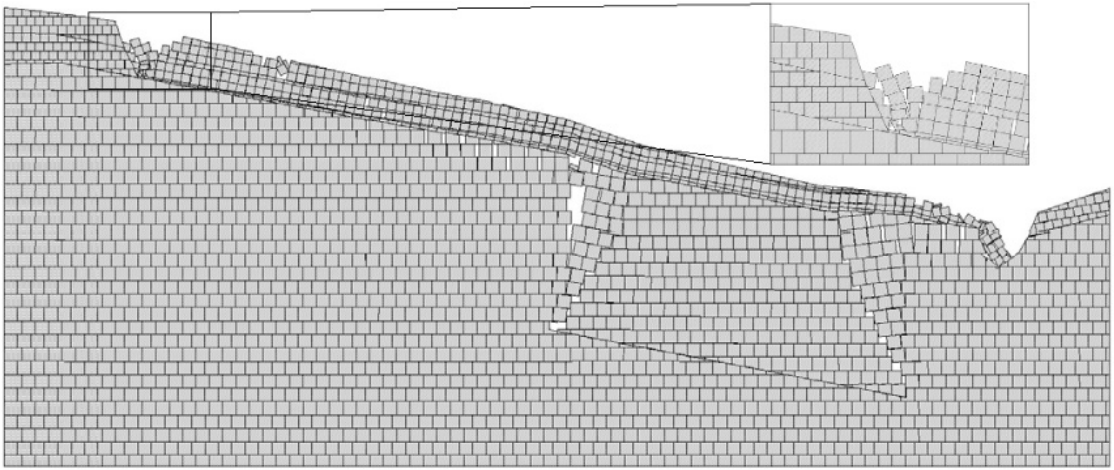
Figure 9. Iterative 607,693-step numerical simulation results.